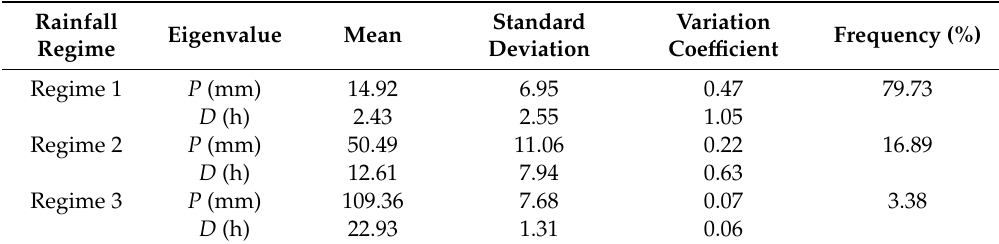
Table 4. Statistical features of the rainfall regimes in XDG and CBG